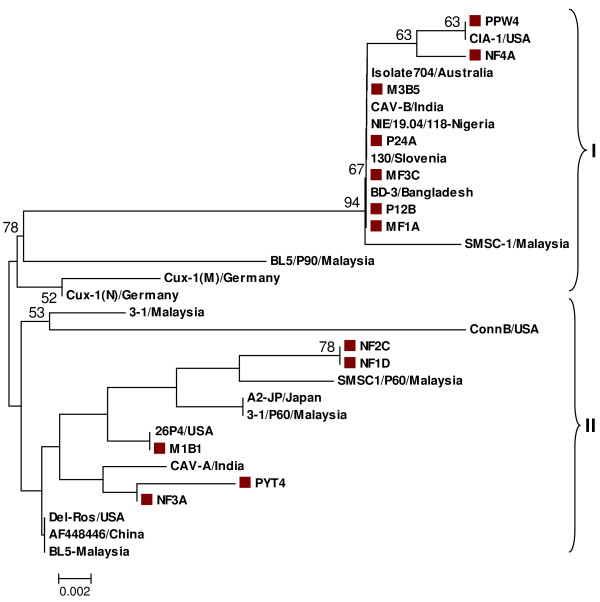
Phylogenetic relationship among 32 different CAV isolates based on partial VP1 amino acid sequences. Note: The boxes (■) indicate isolates identified in this study. The isolates were found both cluster I and II. Seven of the isolates with amino acid profiles of 75-I, 97-L, 139-Q and 144-Q clustered together in cluster I. The remaining five studied isolates with amino acid profiles of 75-V, 97-M, 139-K and 144-E were grouped under cluster II.